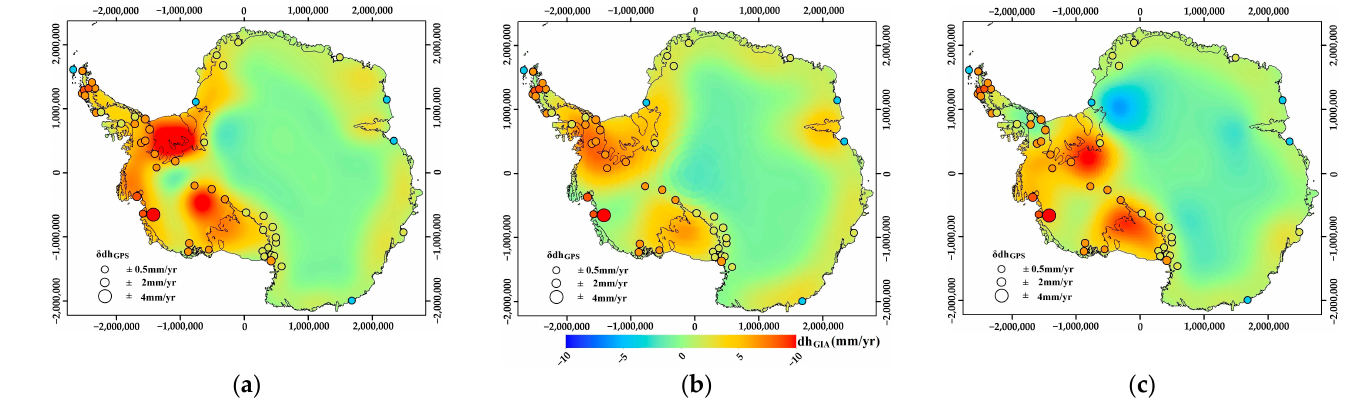
Figure 5. GIA predicated uplift rates from ( a ) ICE-6G, ( b ) IJ05_R2, ( c ) W12a, and uplift rates observed by 57 GPS sites and associated uncertainties during 2003–2009. The color of the circle donates the uplift rate and the radius donates the associated uncertainties.